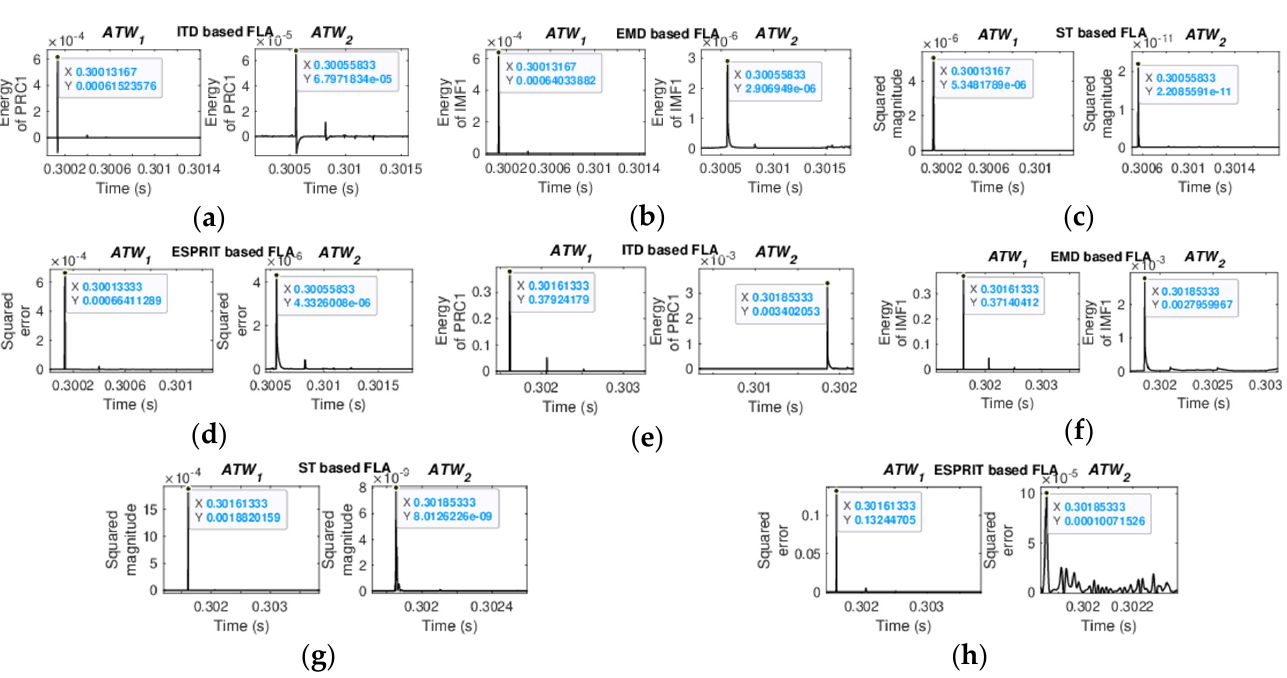
Figure 4. Estimation of ATWs for series-compensated systems for faults before SSSC. ( a – d ) Estimated ATWs for Scenario 1. ( e – h ) Estimated ATWs for Scenario 2.